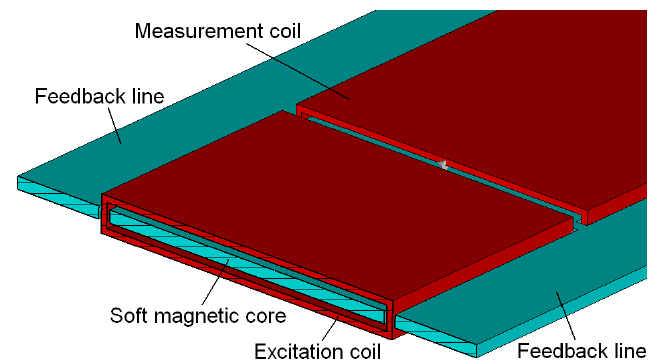
Figure 2. Feedback lines model.